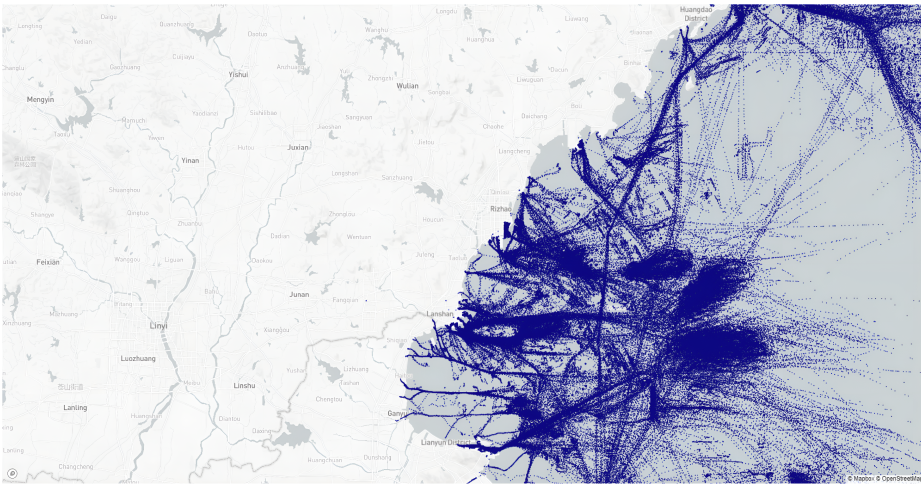
Figure 3. Vessel positions of the Rizhao, China